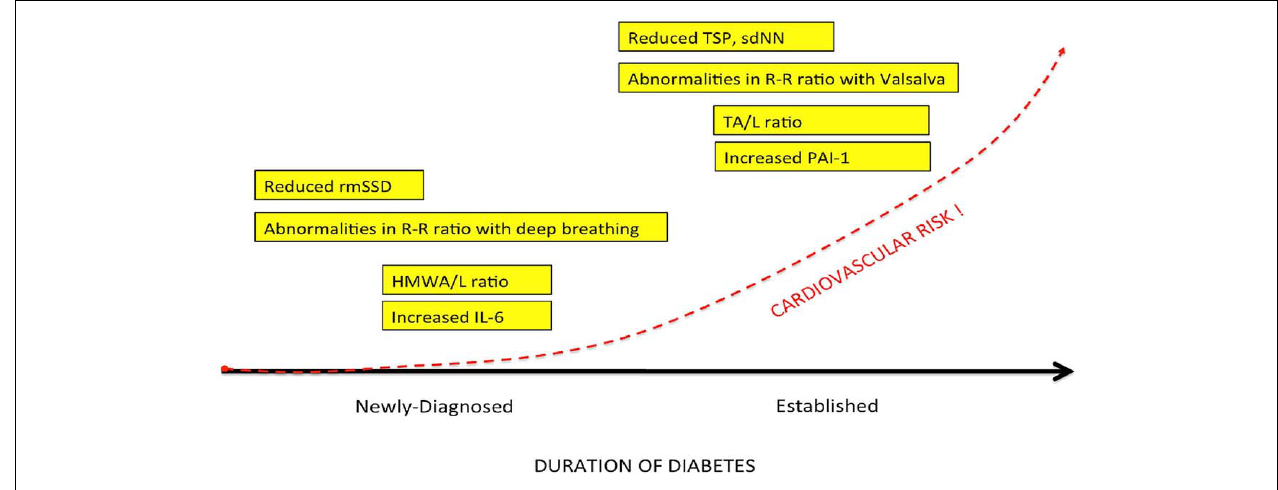
FIGURE 5 |The natural history of autonomic